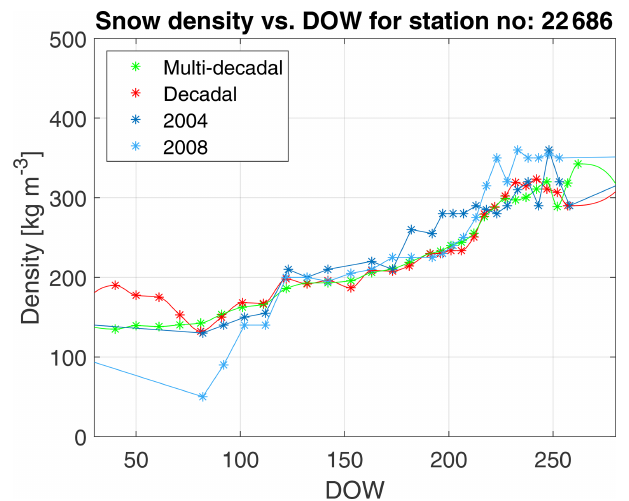
Figure 5. Temporally interpolated densities for snow transects in north central Russia for multi-decadal and decadal versions. The figure also shows results of interpolation for 2 years of annual inter- polation, 2004 and 2008.